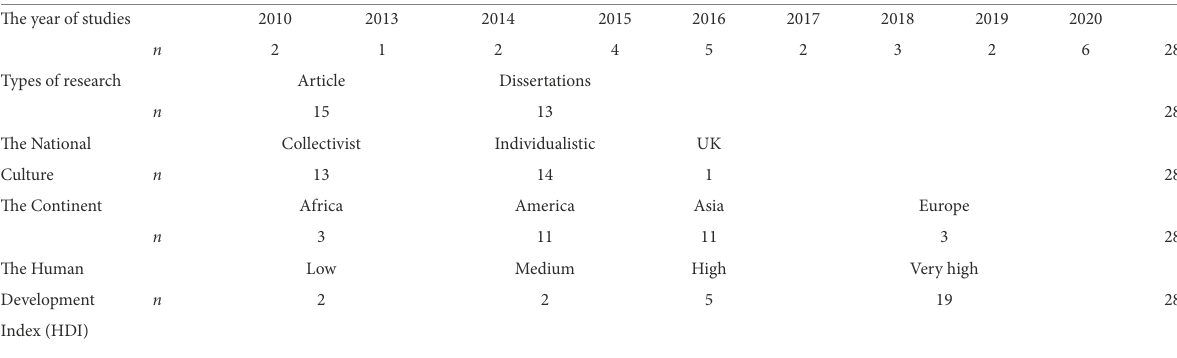
TABLE 1 Frequency of the studies included in meta-analysis of the leadership in HEIs and academic staff’s job satisfaction.